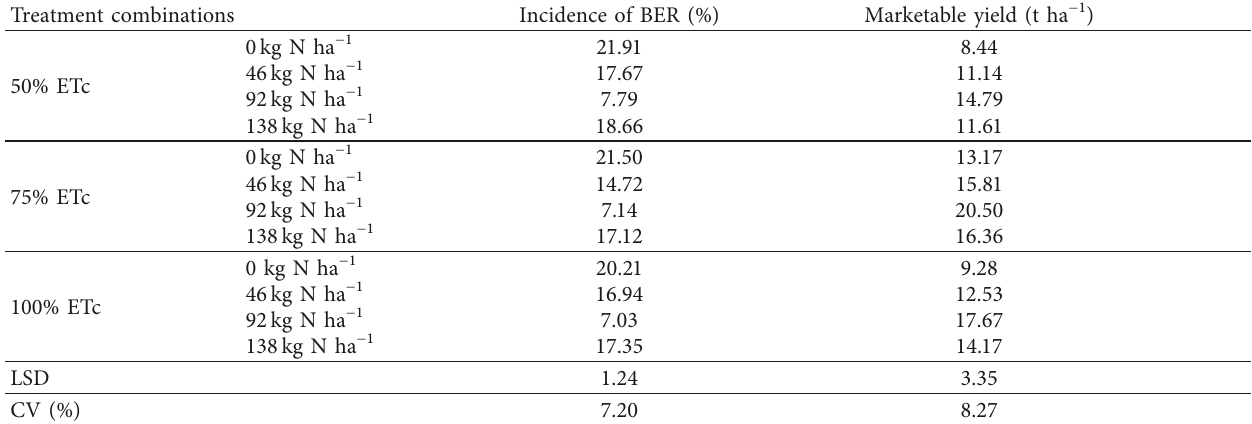
Table 2: Marketable yield and incidence of BER as affected by irrigation and N application levels. Treatment